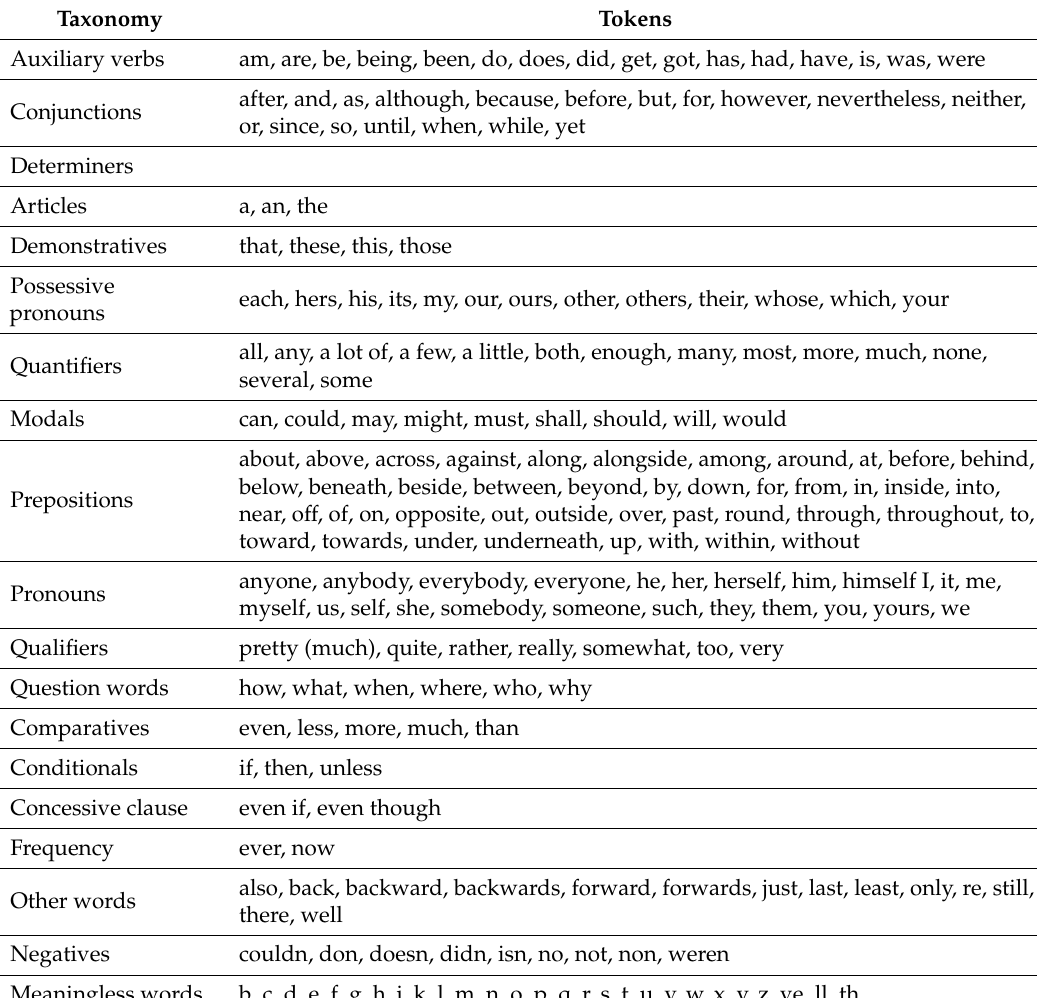
Table 4. A function wordlist